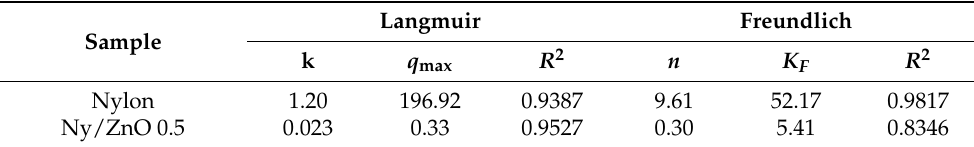
Table 1. Parameters of the isotherm constants and correlation coefficients calculated for urea adsorption.